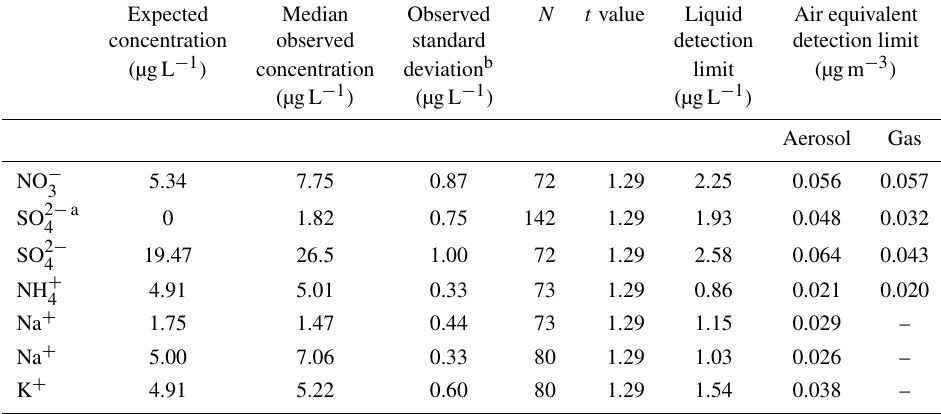
Table 1. Detection limit (liquid and air equivalent) results incorporating data from all four channels for each analyte. Expected Median Observed N t value Liquid Air equivalent concentration observed standard detection detection limit (µgL − 1 ) concentration deviation b limit (µgm − 3 ) (µgL − 1 ) (µgL − 1 ) (µgL − 1 ) Aerosol NO −